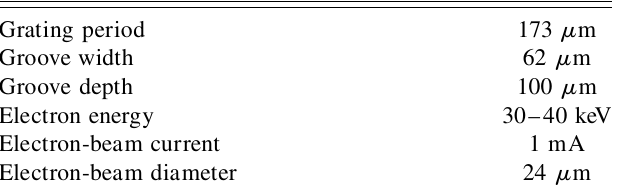
TABLE I. Parameters of a Smith-Purcell FEL, from the data of Urata and